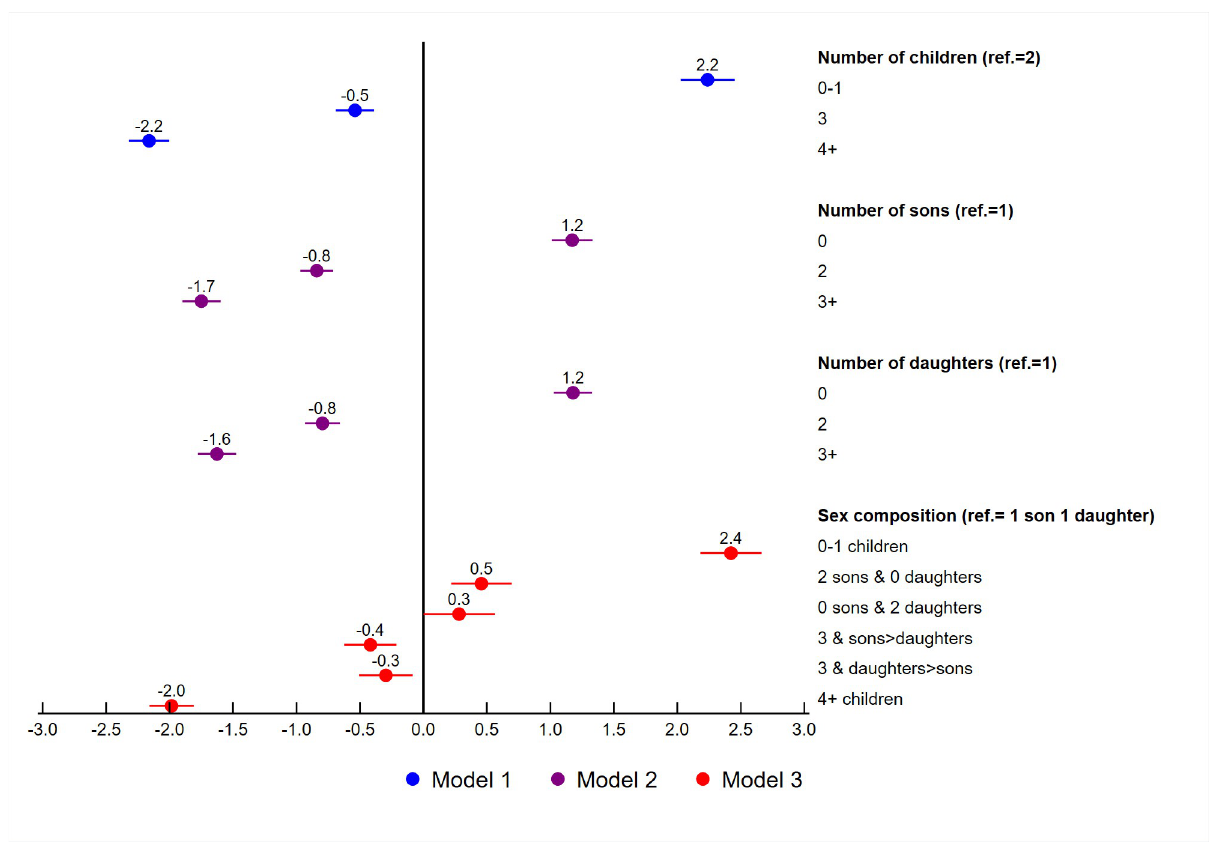
Fig 7. Adjusted regression coefficients for the fertility variables among women age 44–48, South and Southeast